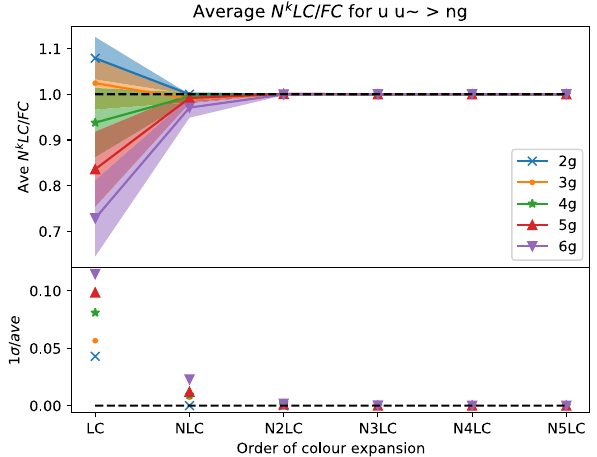
Fig. 4 Same as Fig. 3 but for the process u ¯ u →